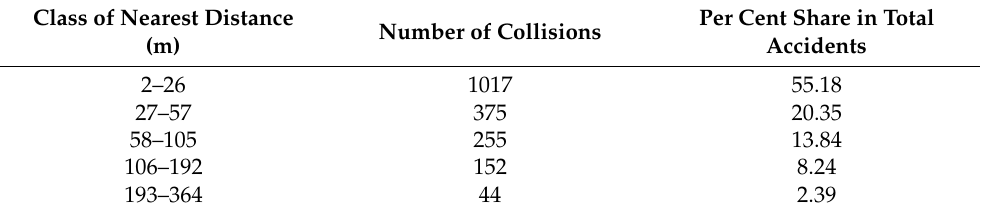
Table 3. Distribution of road accidents by distance to the nearest traffic accident (distance classes were determined according to the natural breaks criterion.